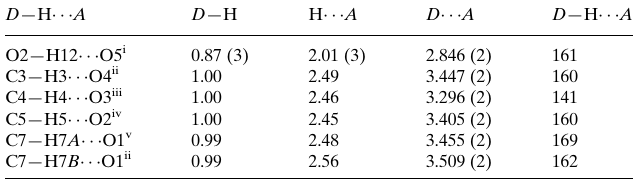
Hydrogen-bond geometry (A˚ , (cid:5)